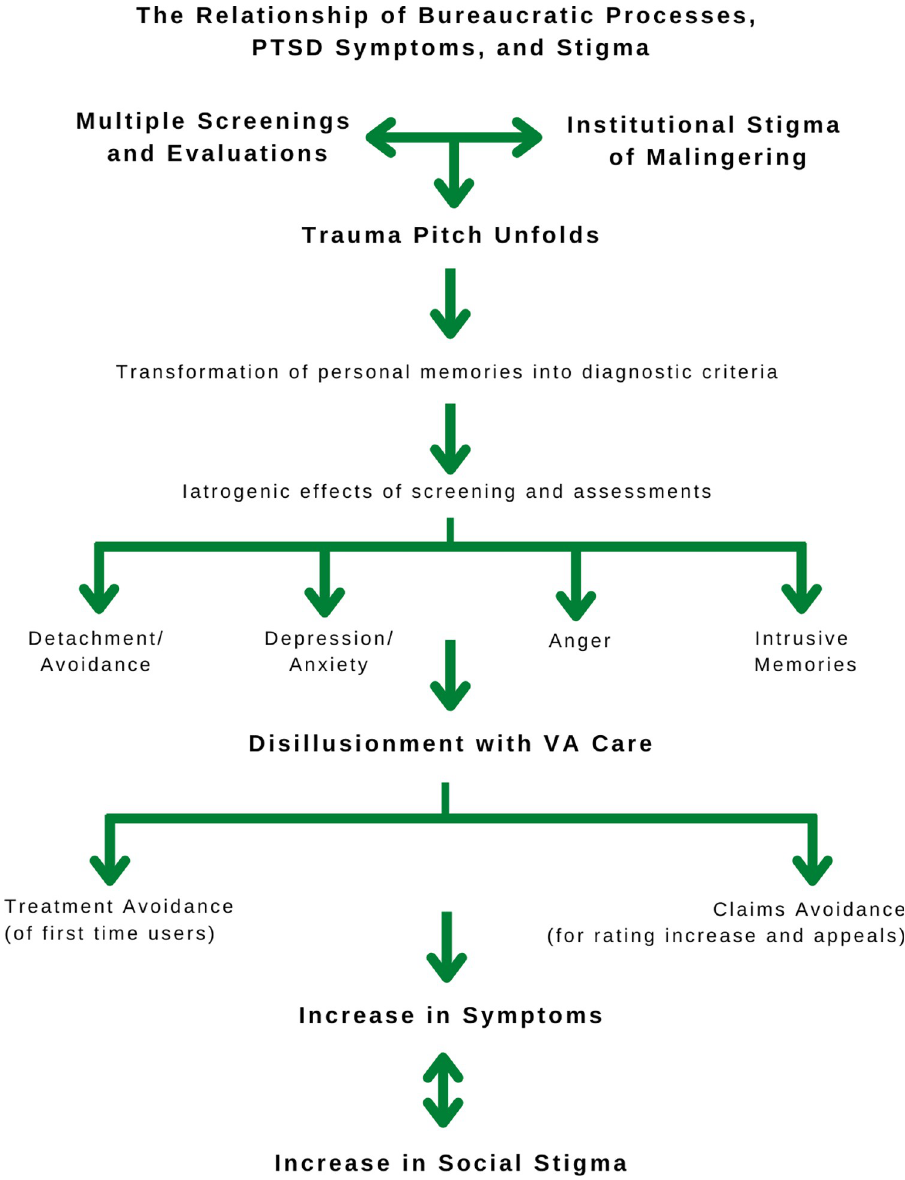
Fig 3. The bureaugenic effects: The relationship between bureaucratic processes, PTSD symptoms and mental health stigma in determining disability compensation for US military